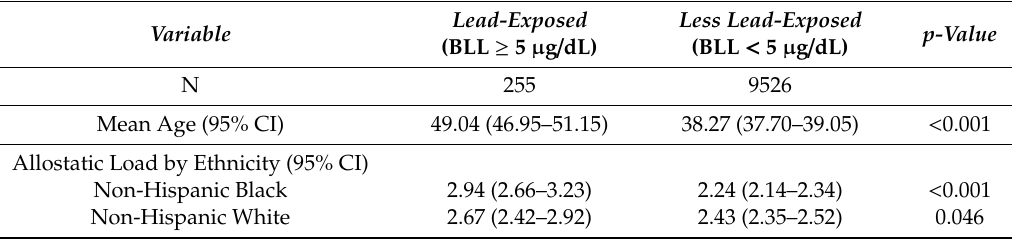
Table 1. The geometric mean values of lead-exposed vs. less lead-exposed of all critical variables in this